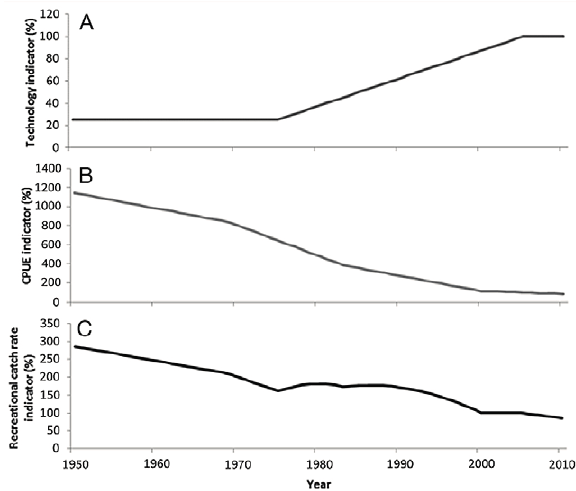
Fig. 8. – Data from recreational fisheries in the Canary Islands, showing the technological creep (A); the CPUE indicator (B); and the cumulative indicator for 1950-2010 (C). The base year is 2005 with